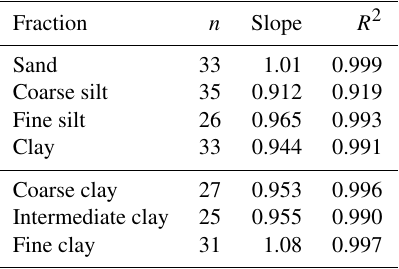
Table 2. Parameters of the carbon yield curves of the Rock-Eval 6 analyses for each analysed fraction ( n : number of analyses). Fraction